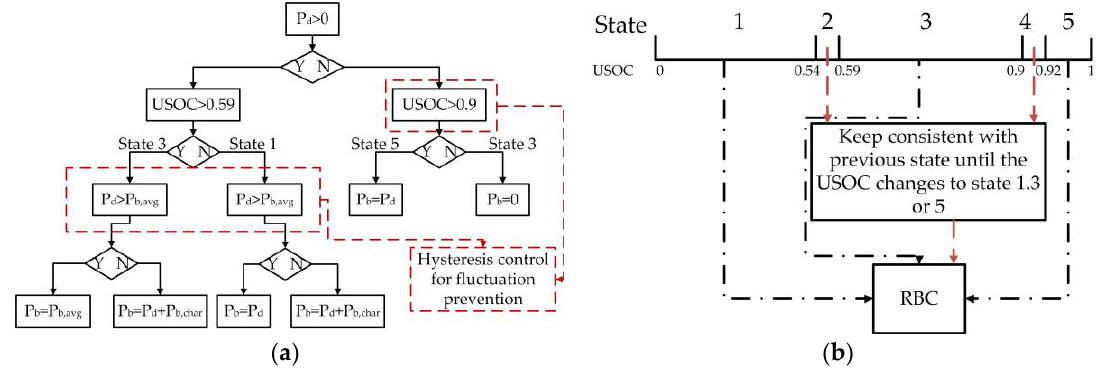
Figure 10. ( a ) RBC process; ( b ) Hysteresis control.